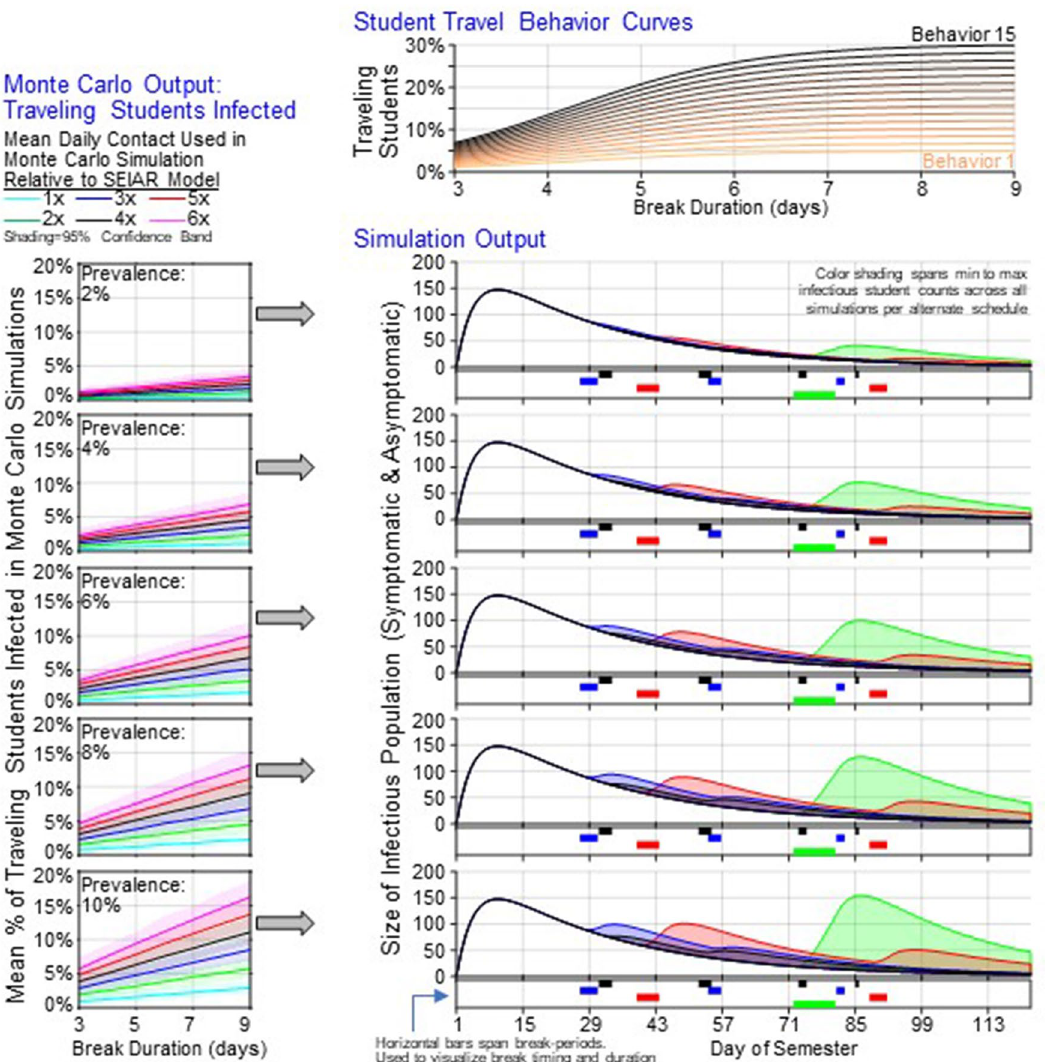
The prevalence rate in each panel provides the rate used in the simulation. Lines are colored by mean daily contact rate used in simulation. Plotted data are mean percent of infectious students. Colored bands show the 95% range of means across 500 simulations. Student Travel Behavior Curves show the relationship between break-duration and percent of students that travel used in simulations. Simulation Output shows the range of infectious student population sizes per alternative schedule (green: one-break, red: two-break, blue: three-break. black: four-break), across all combinations of student travel behavior curves and mean daily contacts while traveling